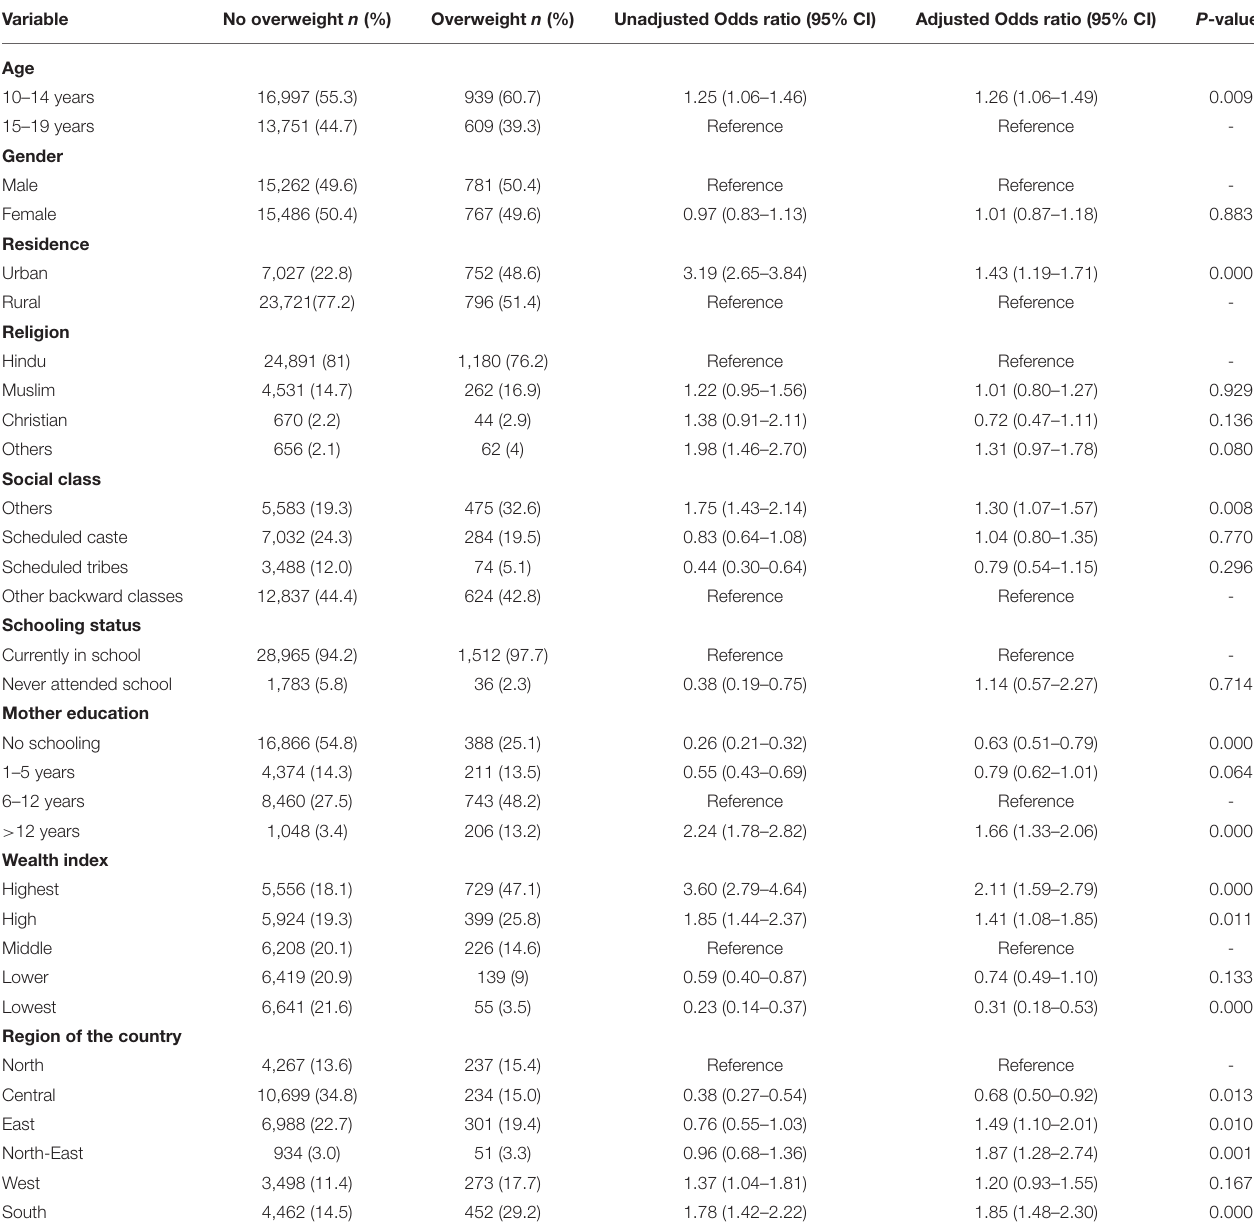
TABLE 4 | Predictors of overweight among adolescent children (10–19 years) of India through Logistic regression model (weighted N = 32,296).